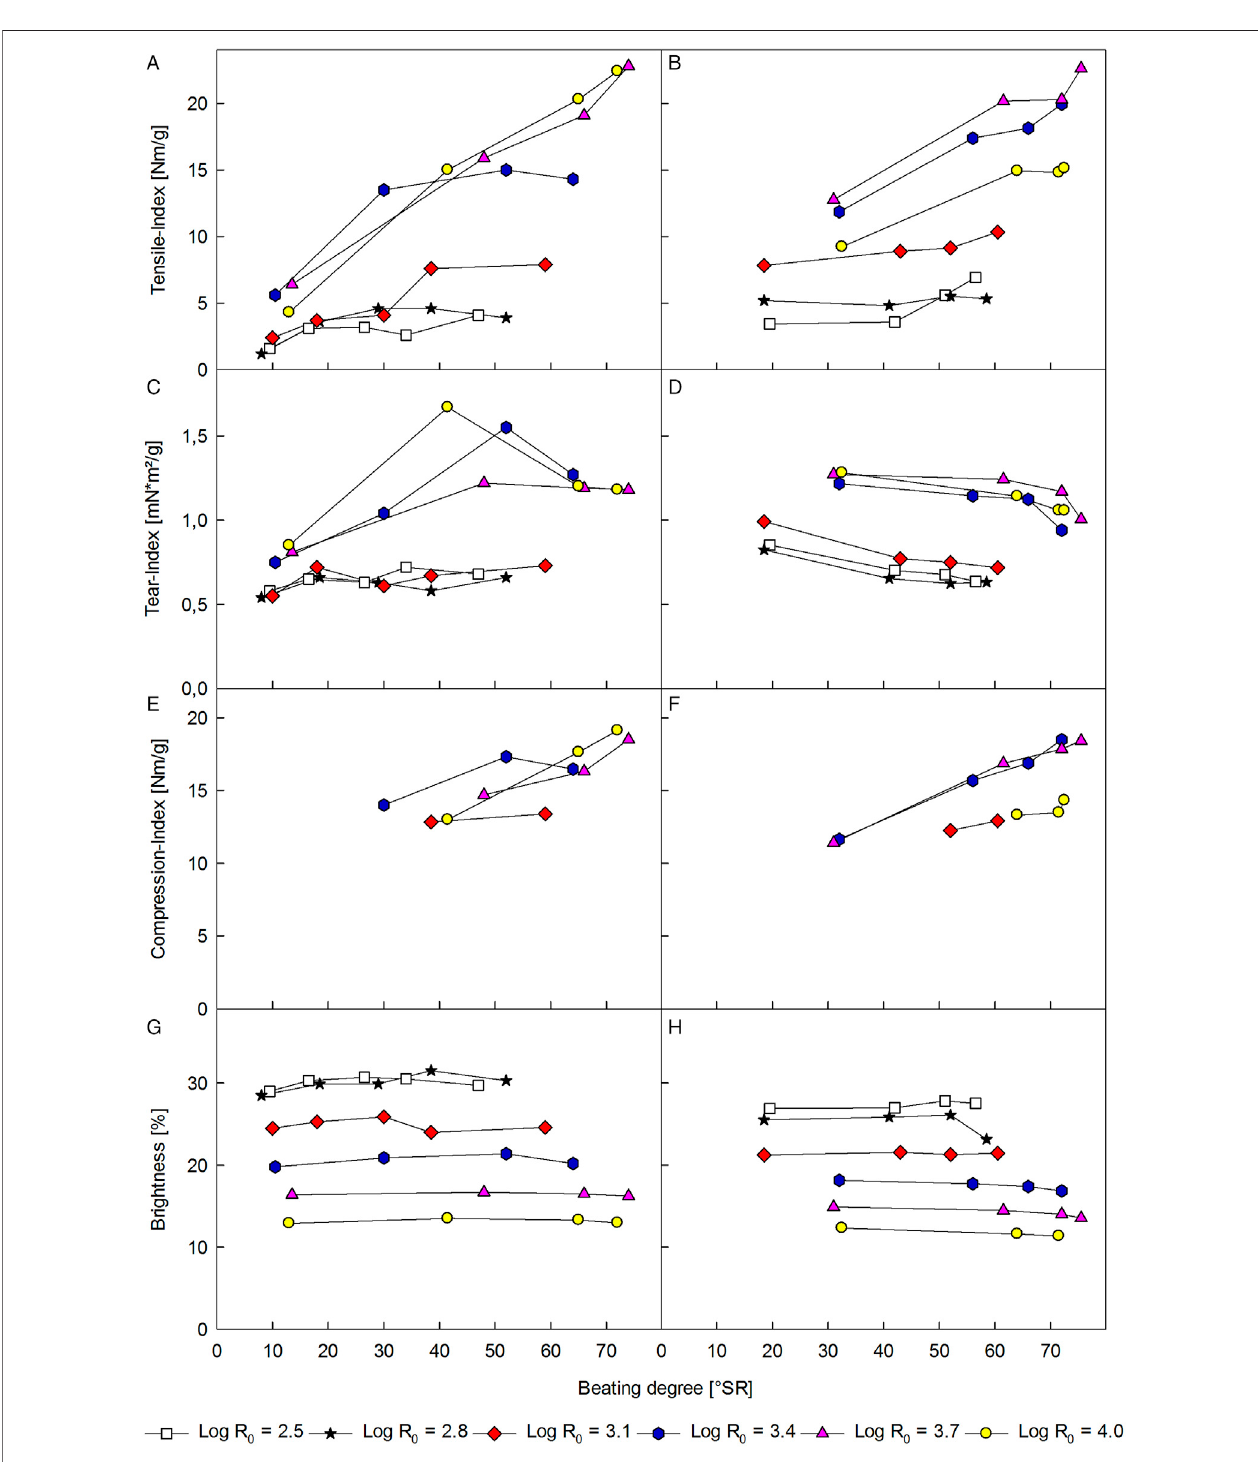
FIGURE 3 | Comparison of the tensile (A,B) , tear (C,D), and compression indices (E,F) and brightness (G,H) of paper test sheets made from steam-treated tree pruning fi bers harvested in winter (left row) and summer (right row) .